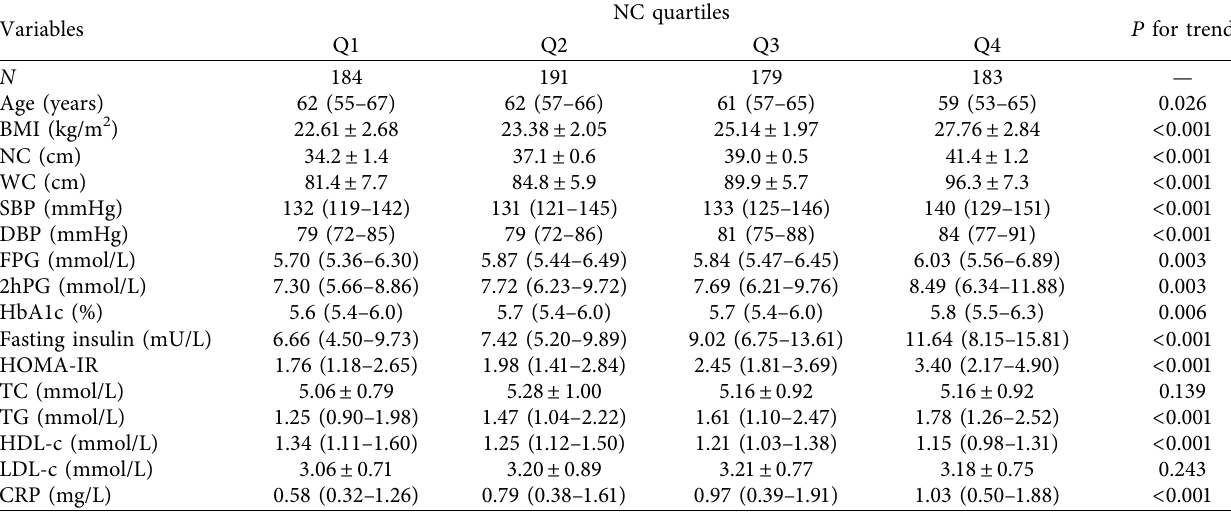
Table 1: Clinical characteristics of the study participants.